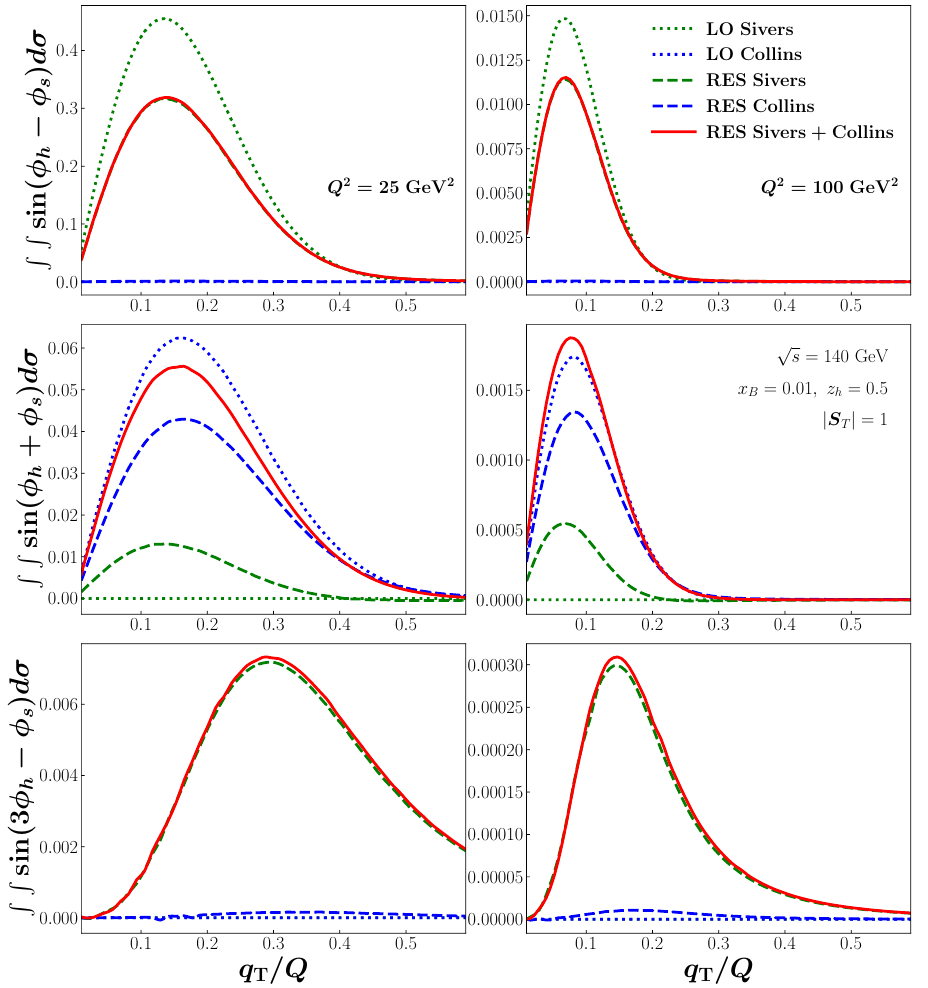
Figure 21 . QED radiation effects for sin( φ h − φ S ) (top) , sin( φ h + φ S ) (middle) and sin(3 φ h − φ S ) √ (bottom) SIDIS UT spin modulations versus q T /Q at s = 140 GeV, x = 0 . 01 , z h = 0 . 5 , and B Q 2 = 25 GeV 2 (left) and 100 GeV 2 (right) , with | S T | = 1 . The cross sections with no QED effects (“LO”, dotted lines) are compared with the QED resummed cross sections (“RES”, dashed lines) for the Sivers (green lines) and Collins (blue lines) asymmetries. The total spin modulations (solid red lines) include the full QED contribution along with leakage